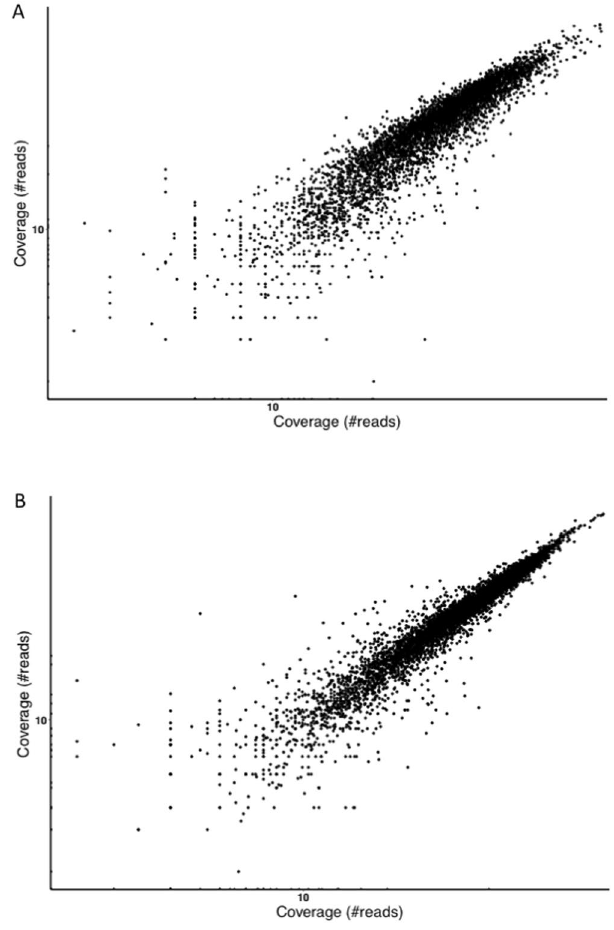
Figure 1. Correlation between the parasite gene expression patterns in two infections. The figure shows the number of reads mapped to each annotated gene (black dots) in the RNA-seq data generated from (A) the infection of patient V_DJK_8 (x-axis) and patient V_DJK_16 (y-axis) and ( B ) the infection of patient V_ DJK_10 (x-axis) and patient V_DJK_16